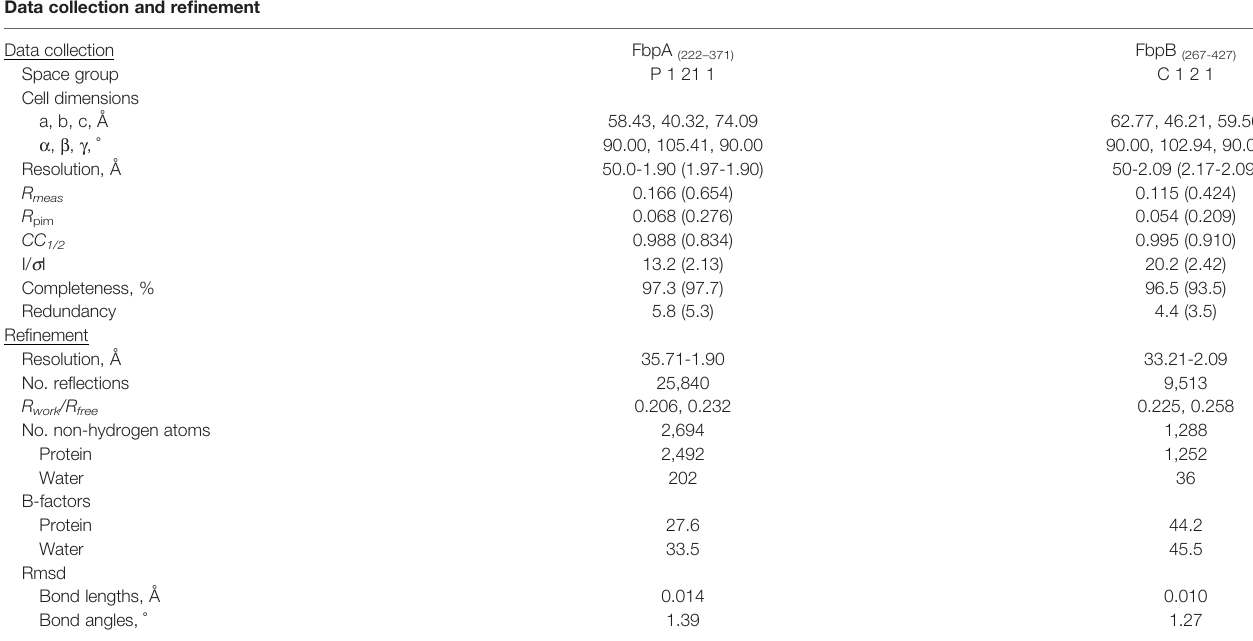
TABLE 3 | Re fi nement data for the solved FbpA and FbpB crystal